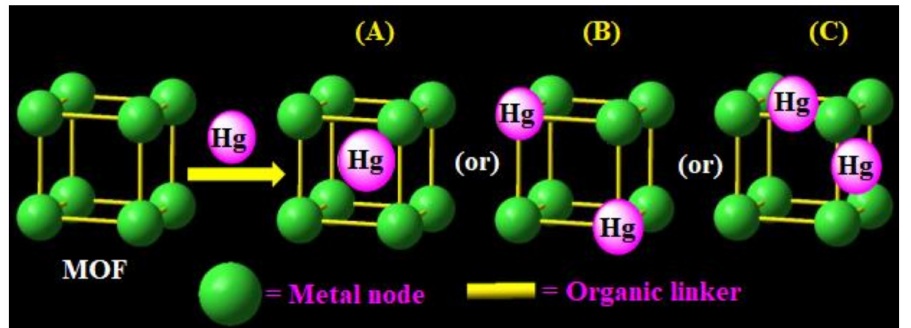
Figure 1. Schematic illustration of three possible MOFs-based mercury detection and removal mechanisms by ( A ) cavity trapping, ( B ) metal node displacement, and ( C ) interactive organic